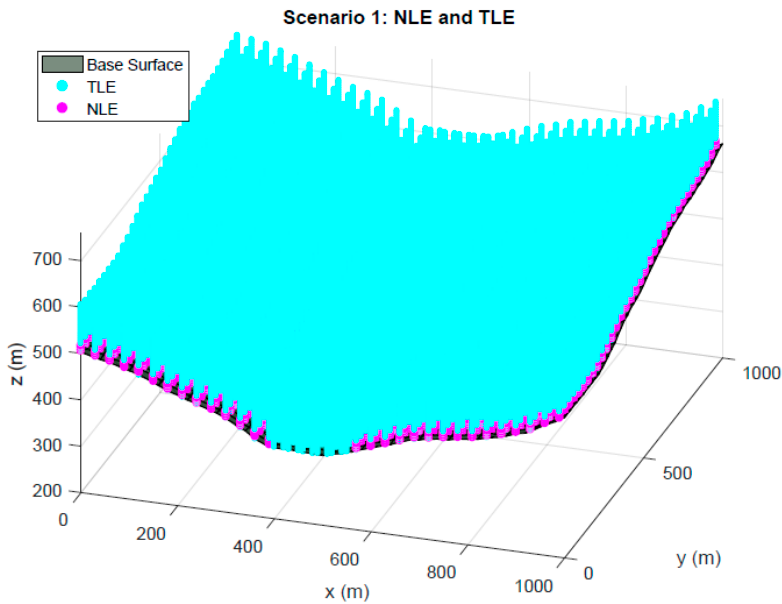
Figure 2. Scenario 1. First environment characterization for optimization with Genetic Algorithms (GA).